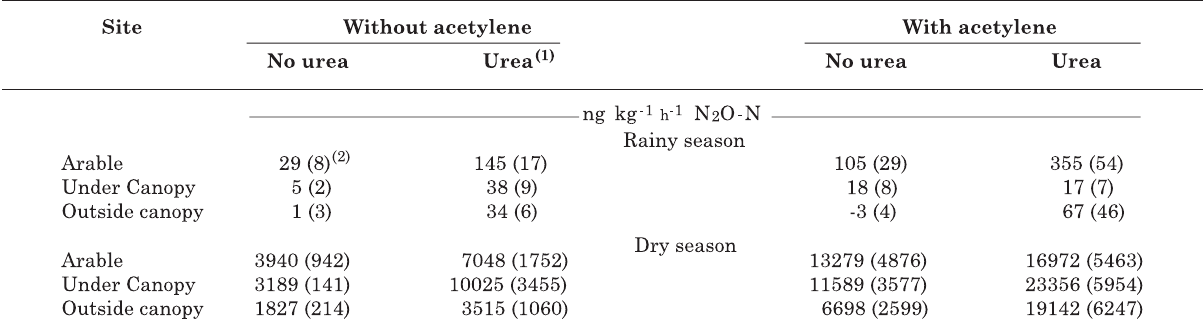
Table 5. N O flux from arable soil and from soil sampled under and outside the canopy of Acacia angustissima 2 in the dry and rainy season and adjusted to 100 % water-holding capacity as determined in measurements after 0, 2, 4 and 6 h